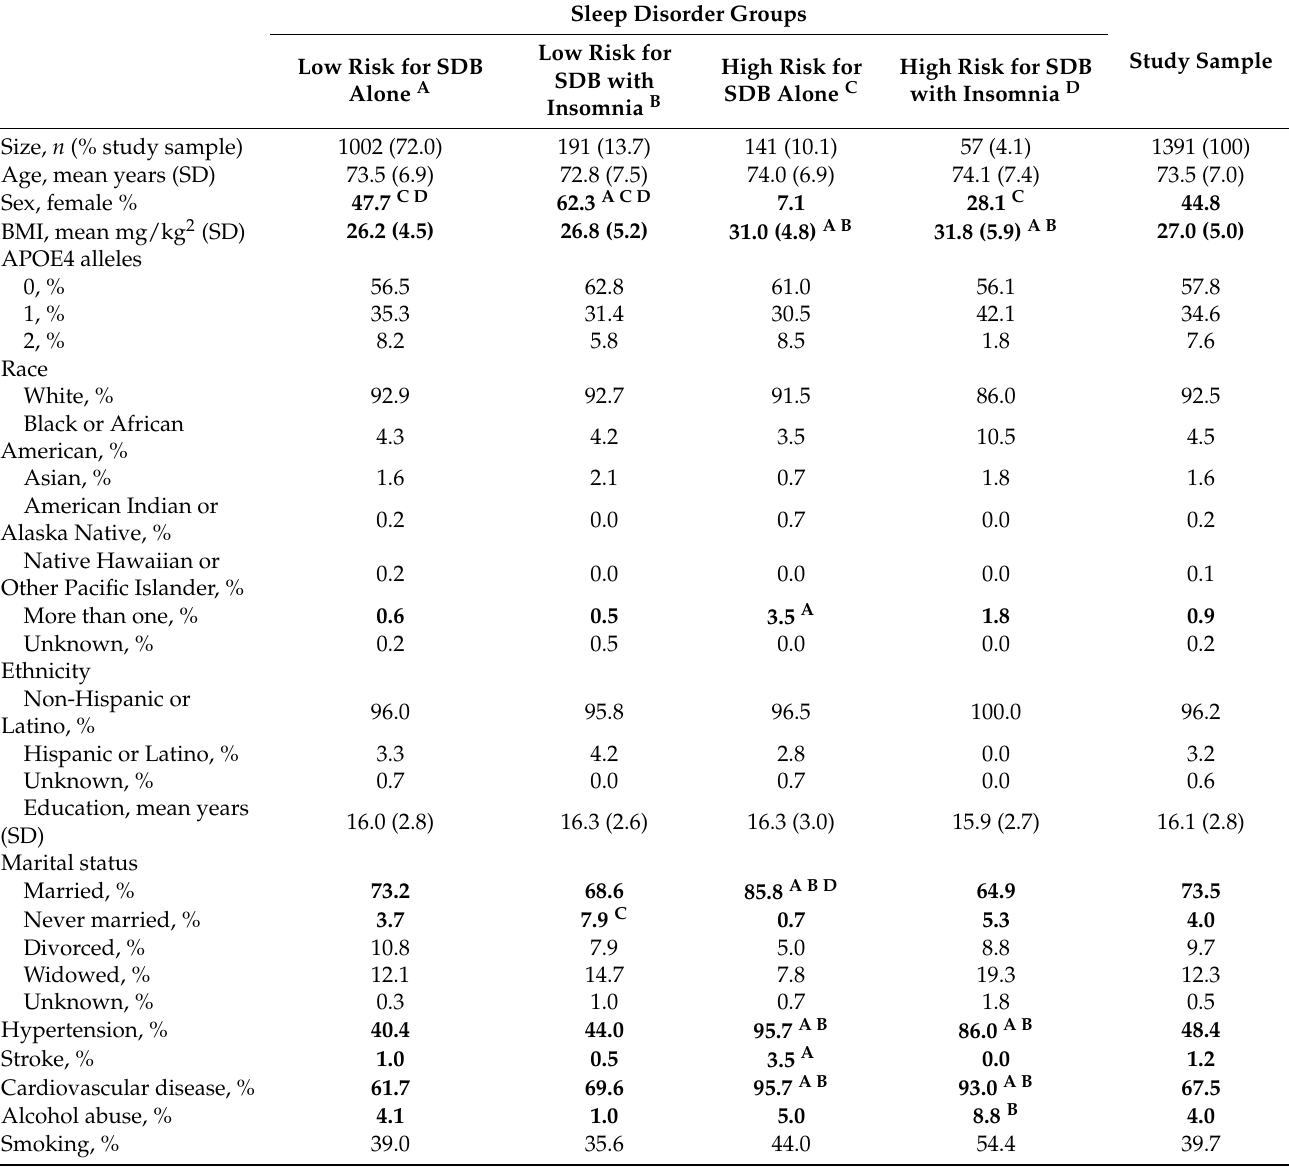
Sleep Disorder Groups